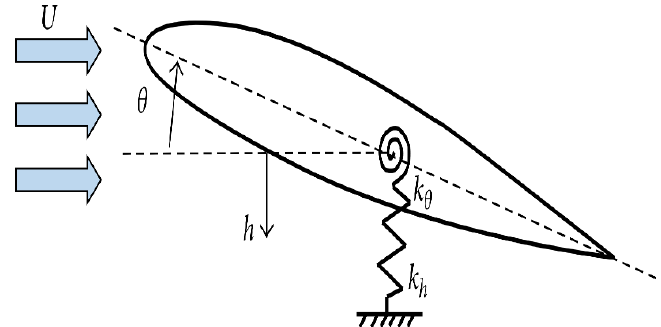
Figure 5. Schematic of an airfoil going through model convergence flutter. Energy harvesters rely on crossflow flutter. The genuine fluttering leaves of a tree subjected to background fluxes inspired this piece. Li and Lipson [97] proposed a device consisting of a polyvinylidene fluoride or polyvinylidene difluoride stock, a plastic pivot, and a three-dimensional polymer “leaf”. The vertical and the horizontal stalk leaf were examined as two alternative layouts with various stalk axis orientations. The highest power density of 615 W was attained with a linked dual-membrane stock of 72 × 16 × 0.41 mm at 8 m/s on a 5 M power, while the highest power density of 2036 W/m 3 was attained at 7 m/s on a 30 M force, using a unimorph-limited stem measuring 41 × 8 × 0.205